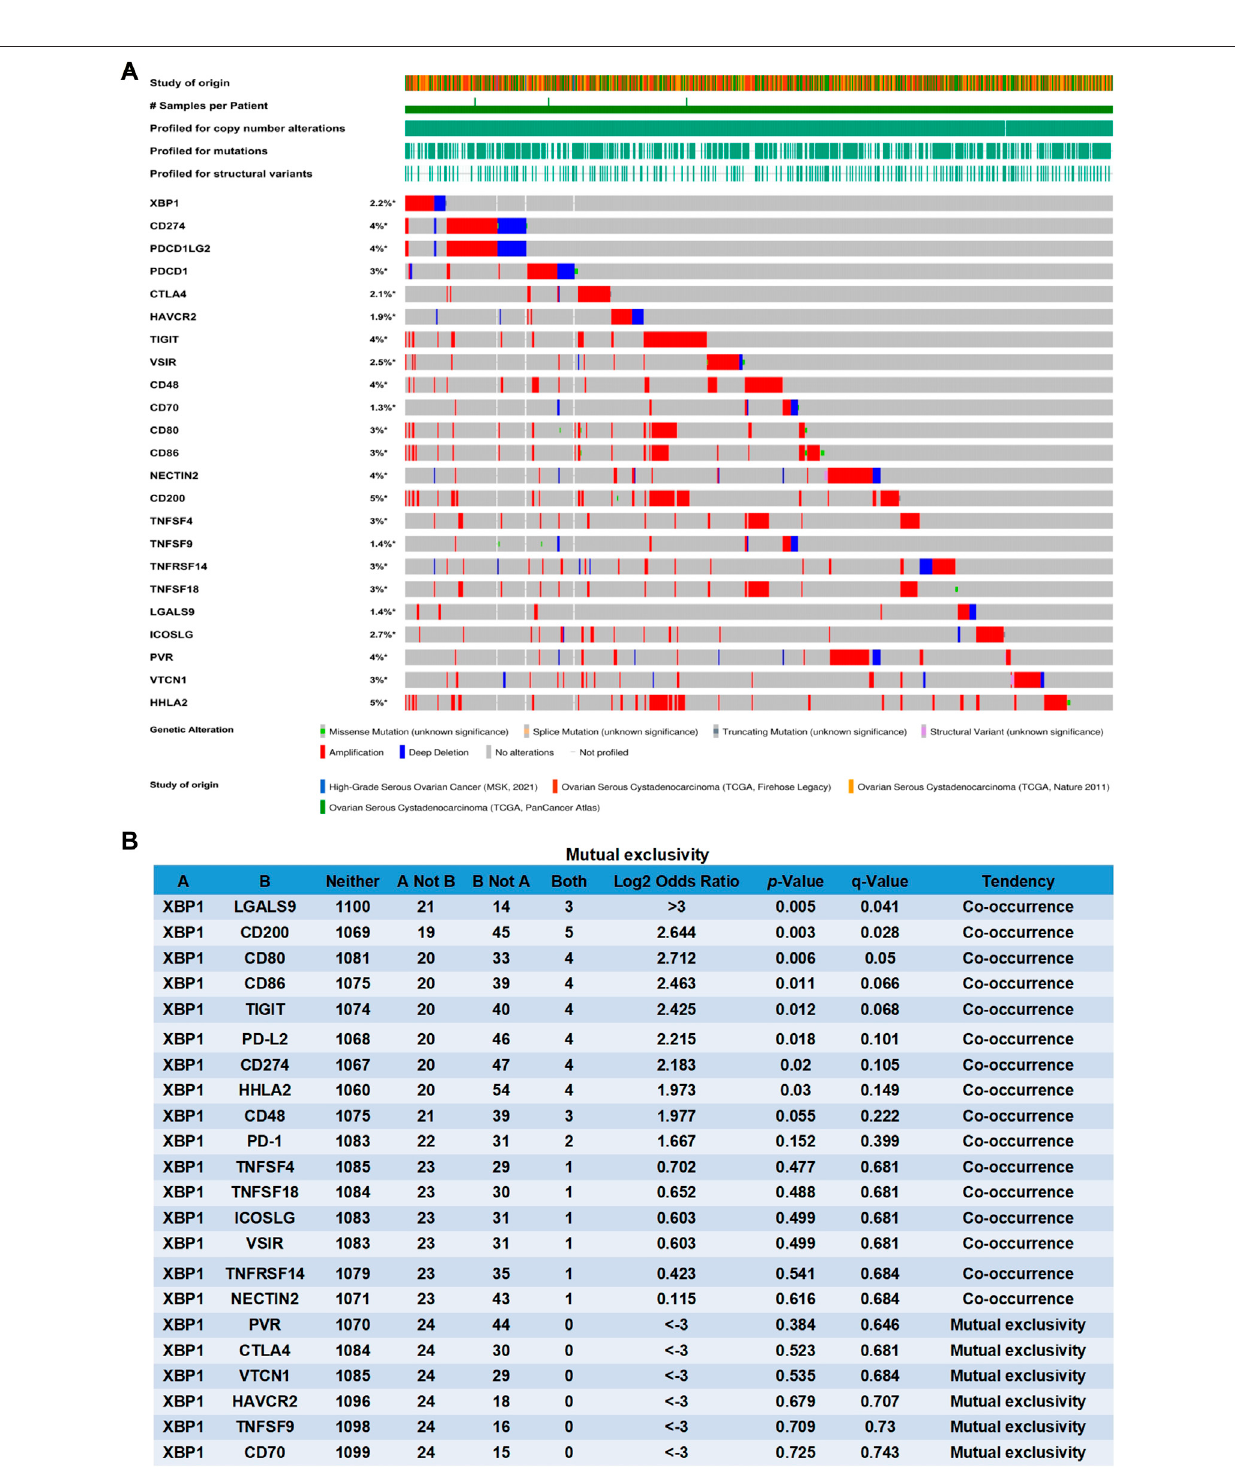
FIGURE 2 | XBP1 is a potential coregulator of immune checkpoints in ovarian cancer. (A) Oncoprint of XBP1 and immune checkpoint alteration in ovarian cancer. Summative visualization of cases with multiple genetic alterations of XBP1 and immune checkpoints (originated from four studies) were individually shown by cBioPortal as indicated, including deep deletion, ampli fi cation, structural variant, truncating mutation, missense mutation, and splice mutation. (B) Mutual-exclusivity analysis betweenXBP1andmultiple-immunecheckpointsinovariancancer.Thealtered relationshipbetweenXBP1andeachimmunecheckpoint,such asco-occurrence and mutual exclusivity, was presented as indicated. The detailed log2 odds ratio, p -value, q-value, and tendency were individually presented in each panel. log2 odds ratio > 0wasconsideredtobeCo-occurrenceandlog2 oddsratio < 0wasconsidered tobeMutualexclusivity.Thestaticallysigni fi cantdifference wasconsidered whena p -value or q-value is <